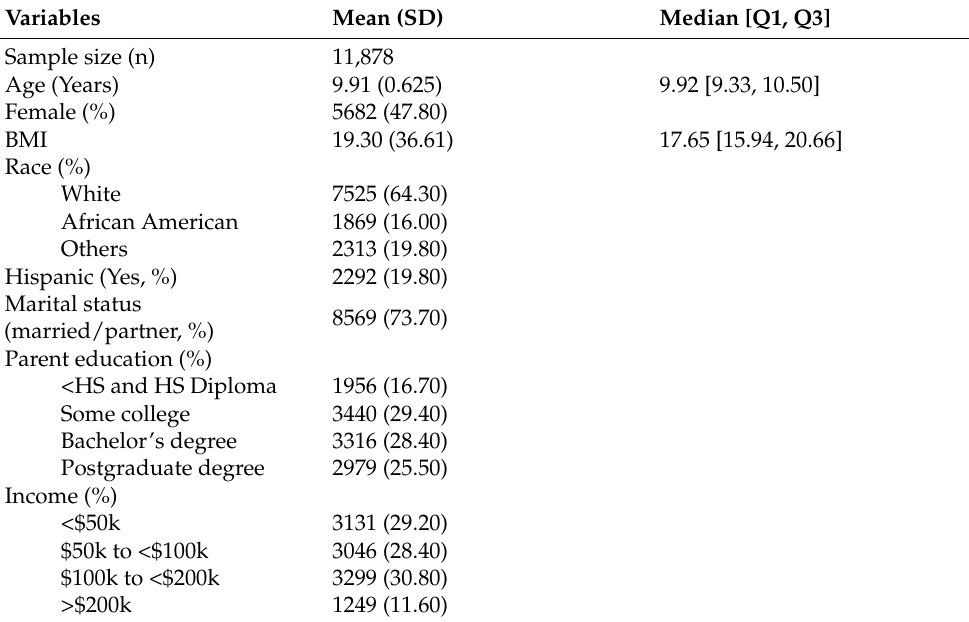
Table 1. Baseline descriptive characteristics of ABCD Study population